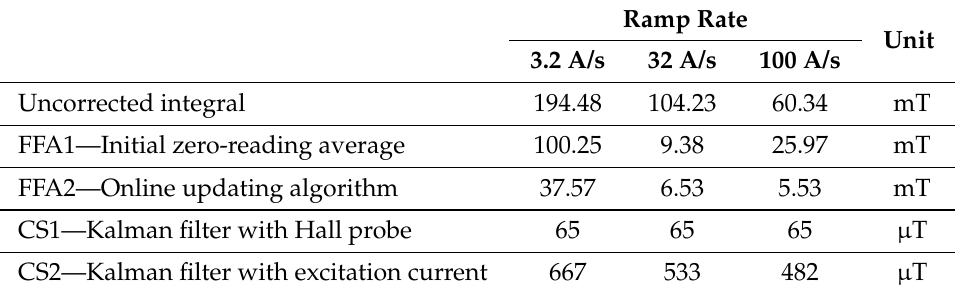
Table 3. Total uncertainty values σ B , end defined according to Equation